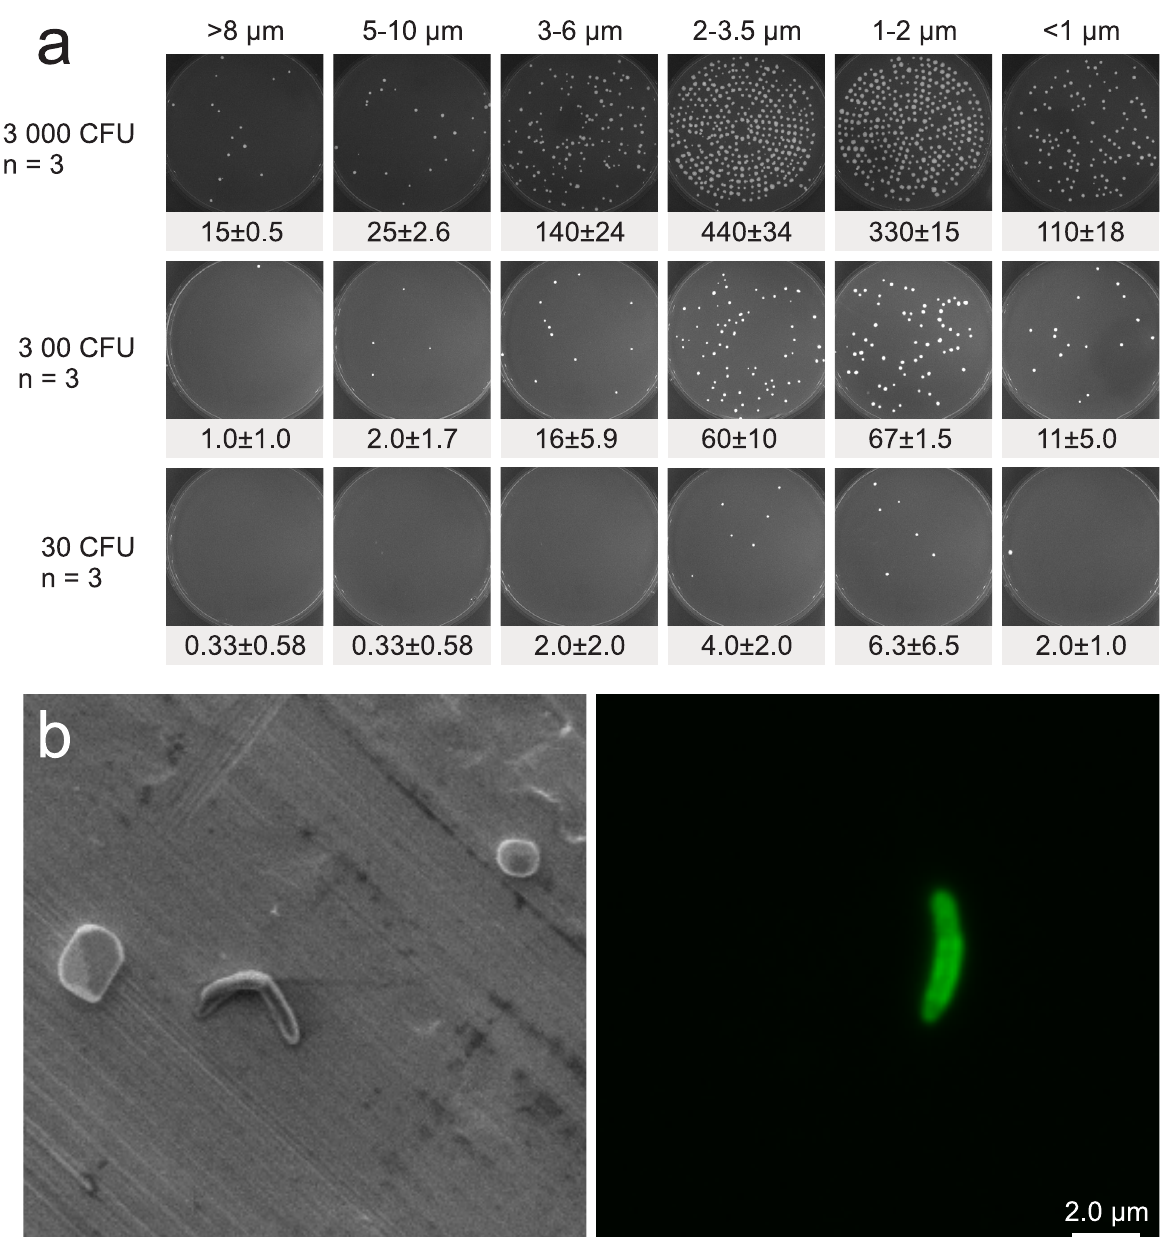
Fig 4. Isolation and visualization of viable mycobacteria in the RASC. (A) M . smegmatis :: gfp growth on solid 7H10 agar plates from the Six-Stage Viable Andersen Cascade Impactor after wet release of 200 μ l diluted culture into the RASC (30 000, 3000 and 300 colony forming units — CFU). The columns indicate the particle sizes captured on each plate across the 6 stages of the impactor, and the rows indicate the estimated total number of CFU passing through the impactor. Each release was repeated three times and the mean and SD for each plate are presented below the typical growth pattern distribution seen in the particle release. In all the releases the sampling was run for 5 minutes at 28 l/min resulting in the potential total capture of 3000, 300 and 30 CFU respectively. (B) SEM (left) and fluorescent microscopy (right) of M . smegmatis :: gfp isolated on a PM10 impactor following experimental release.